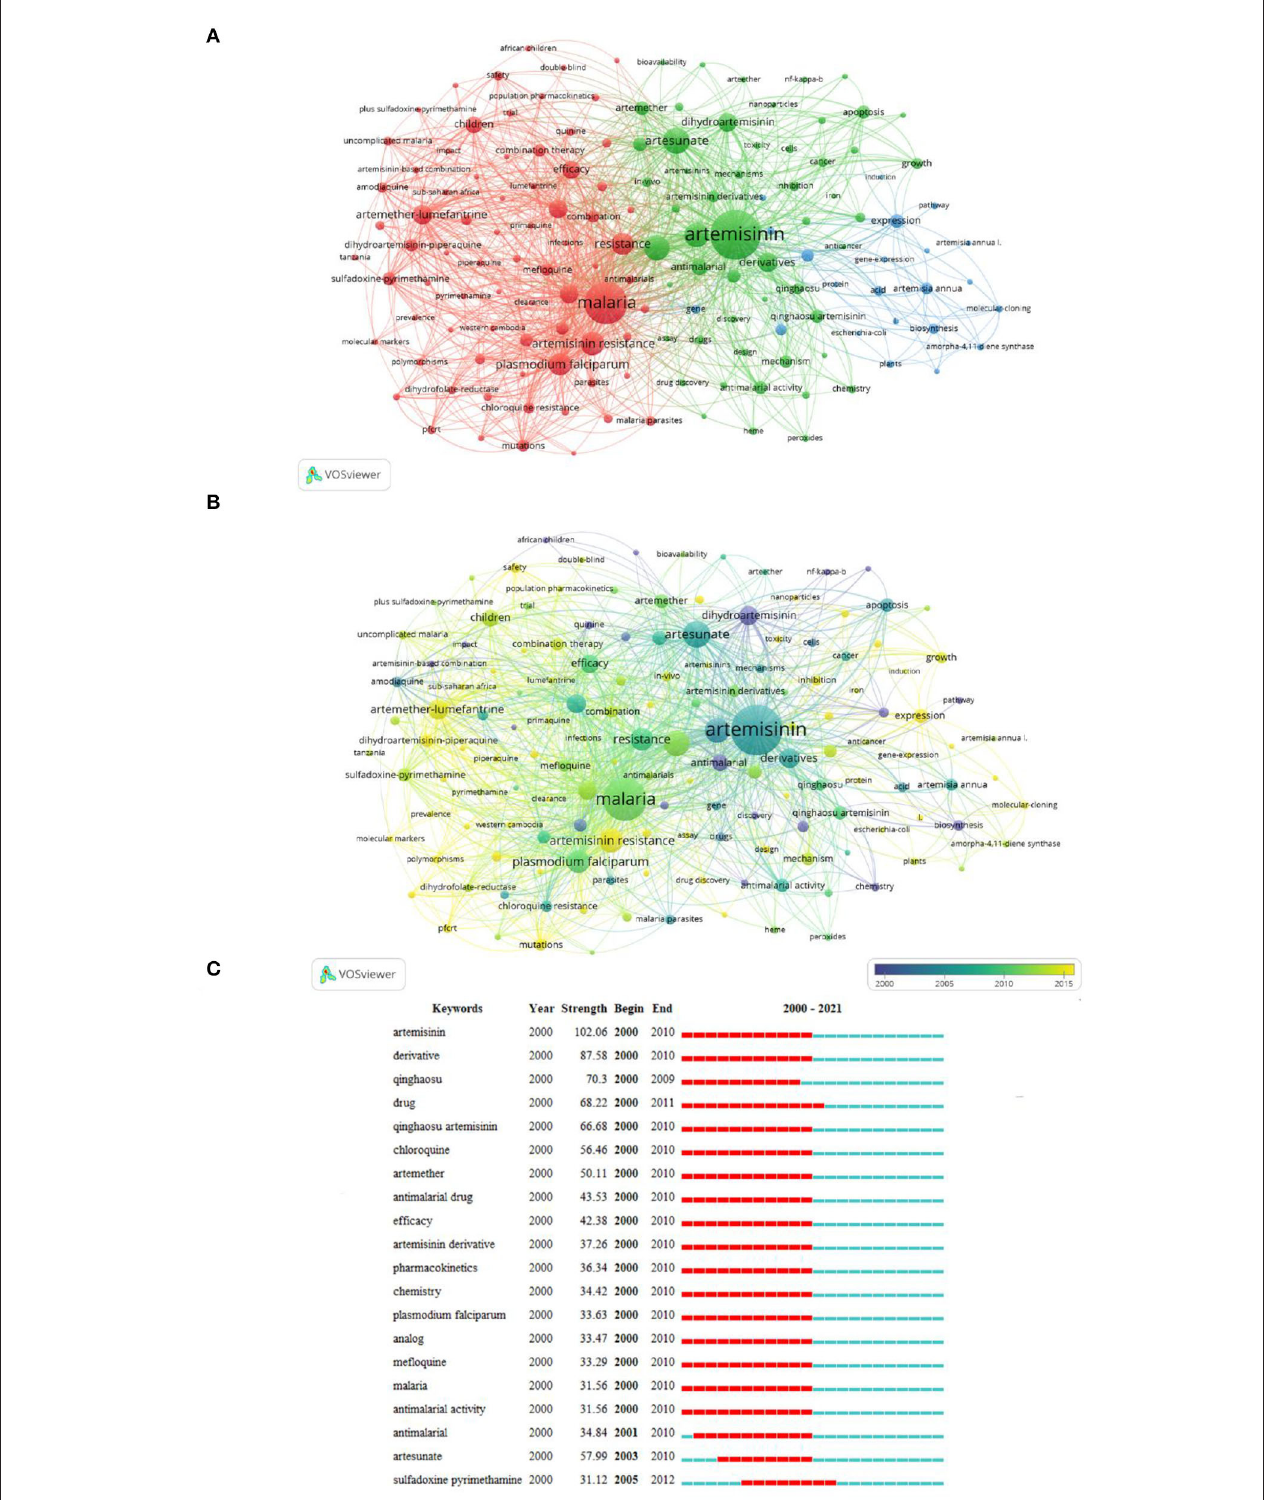
FIGURE 7 | Network on keywords of artemisinin. (A) The 150 keywords that occurred more than 80 times were divided into 3 clusters by different colors: cluster 1: red, cluster 2: green, cluster 3: blue. The size of the nodes represents the frequency of occurrences. (B) Visualization of keywords according to the average publication year (APY). Keywords in yellow appeared later than that in blue. (C) Top 20 representative burst keywords.